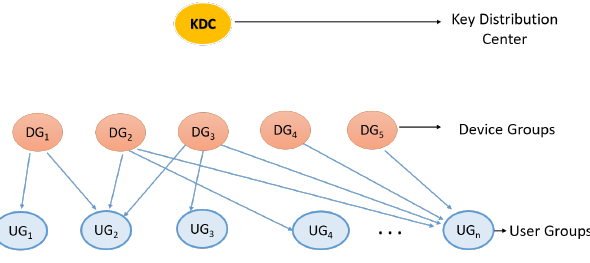
Figure 1. There are five device groups, DG 1 , . . . , DG 5 , and n user groups, UG 1 , . . . , UG n . UG 1 subscribes only to DG 1 , UG 2 subscribes to DG 1 , DG 2 and DG 3 , and so